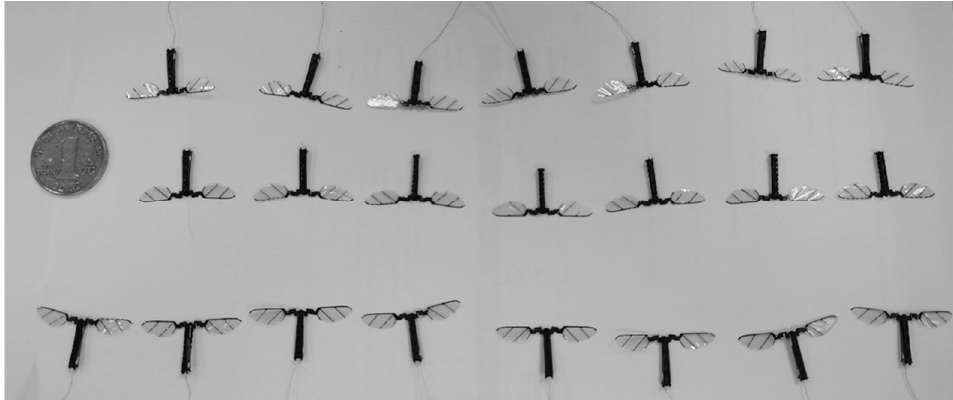
Figure 11. The flapping ‐ wing air vehicle was obtained by batch production .